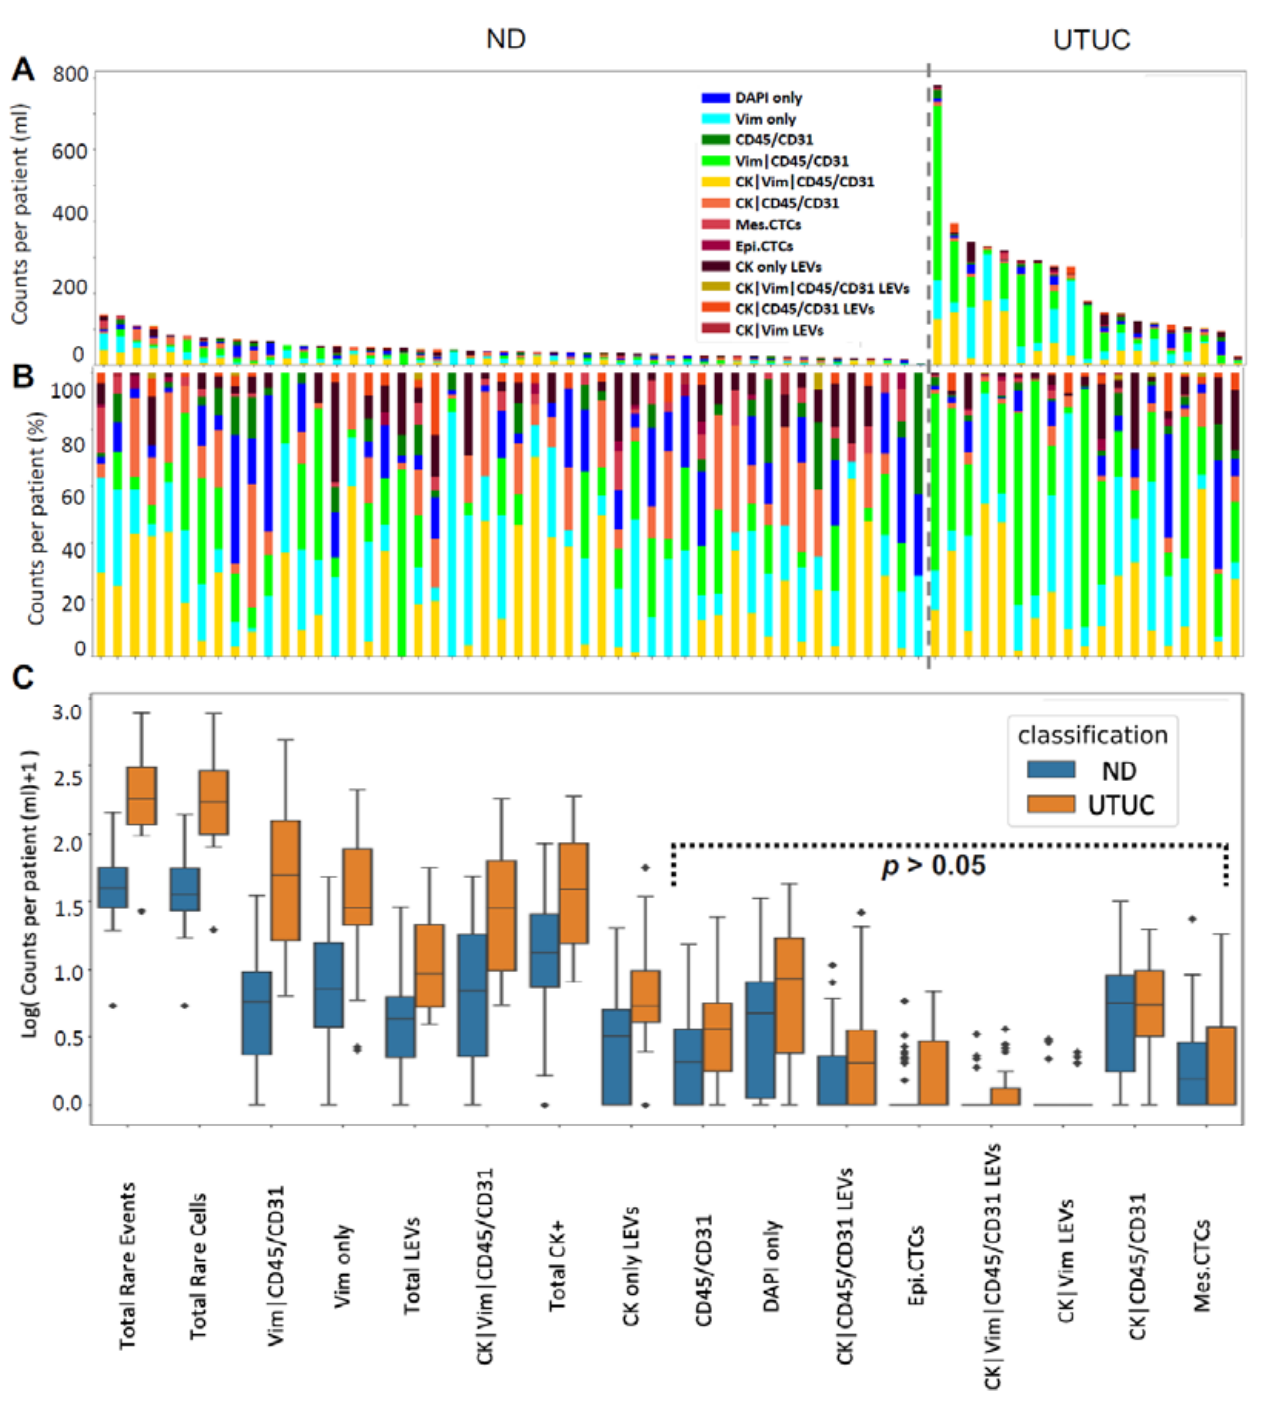
Figure 2. Rare-event detection in PB samples collected from UTUC patients prior to surgery using HDSCA3.0. ( A ) Enumeration and ( B ) frequency of each rare event by channel-type classification. ( C ) Graphical representation of the channel-type rare events/mL ordered by degree of statistical significance between UTUC and ND samples. Channel-type specifications that were not statistically significant across ND and UTUC samples are highlighted ( p -value > 0.05). Diamond points indicate outliers. Total CK-positive cells were detected with a median of 37.91 events/mL (range 7.06–186.59; mean 60.37) from all UTUC samples. The ND samples had a median of 12.40